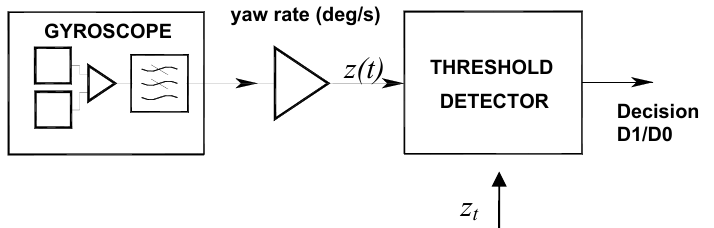
Figure 5. Simple threshold detector based on the comparison of a low-pass filtered turn rate z(t) with a preset threshold z